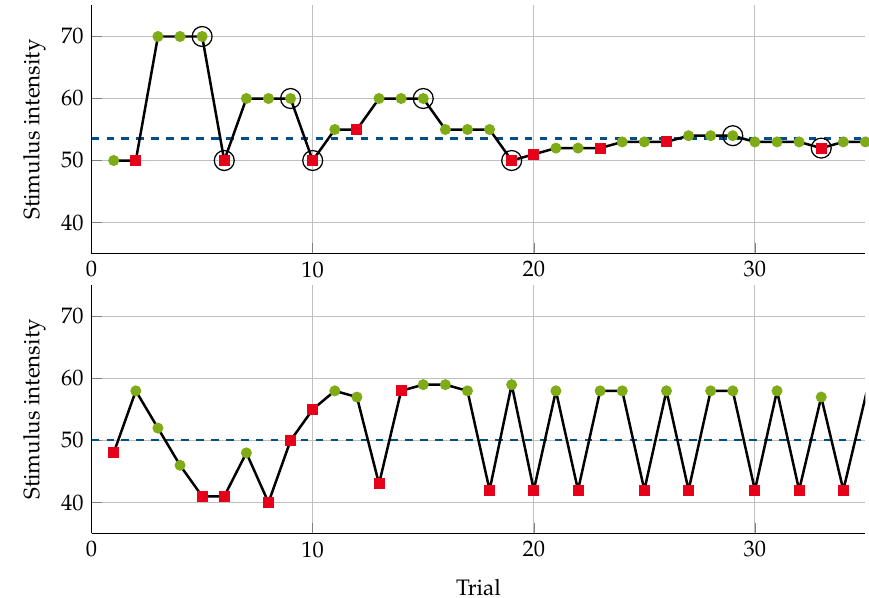
Figure 2. Examples of psychometric methods: Transformed Up-Down-Staircase with 1up-3down progression rule ( top ) and Ψ ( bottom ). Graphs are taken from a simulation and show the tested stimulus intensity for each trail. Red squares denote negative, green dots denote positive responses of the test persons to the stimulus. The dotted line shows the calculated threshold, and reversals of the staircase method are denoted by larger